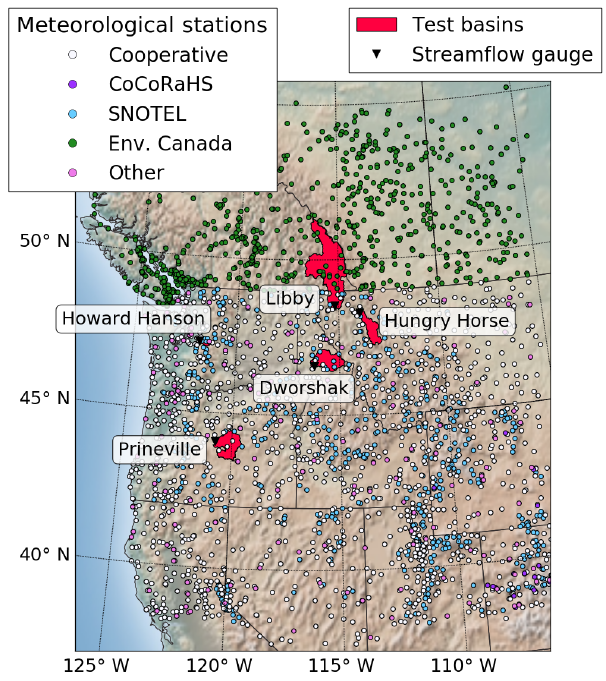
Figure 1. Location map with the pilot basins included in this study.